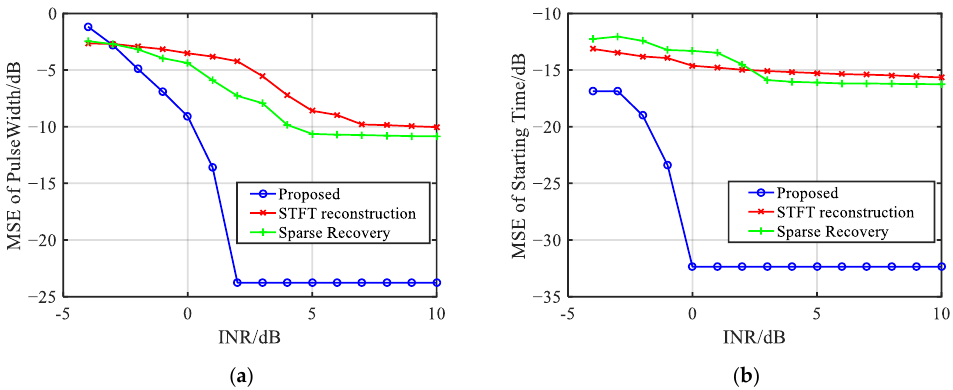
Figure 10. Comparison of the MSE calculated from: ( a ) Pulse width estimation; ( b ) Starting time estimation.